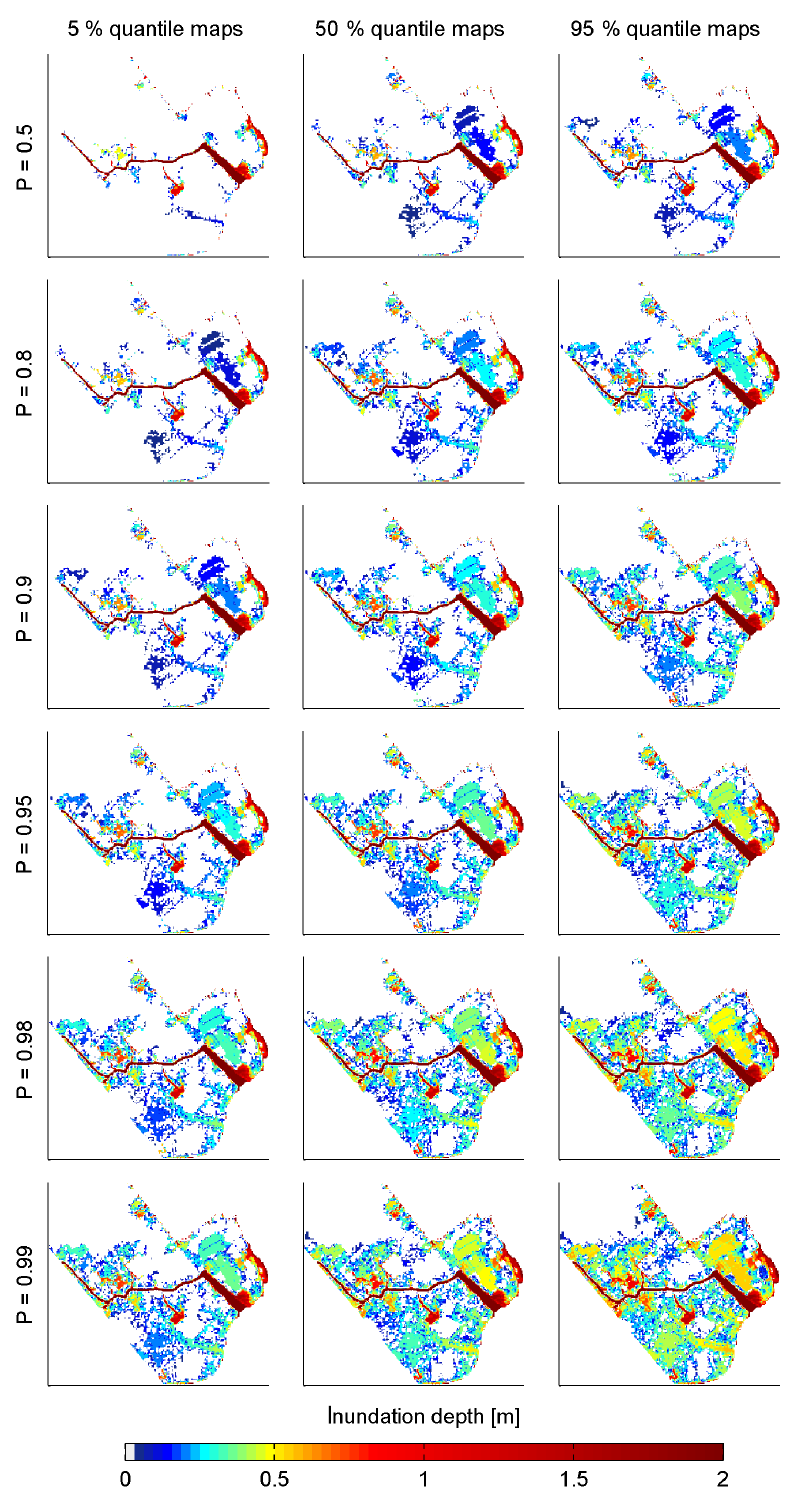
Figure 12. Probabilistic fluvial flood hazard maps for Can Tho showing maximum inundation depths: for the selected p levels (annual probabilities of non-exceedance) the median (50% quantile) maps and associated 5 and 95% quantile maps are shown illustrating the uncertainty of the hazard estimation. Maximum inundation depths < 0.02m are indicated as no